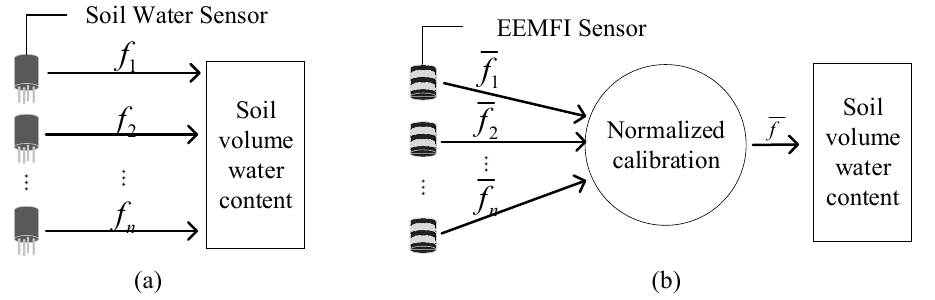
Figure 7. Comparison of calibration methods: ( a ) traditional calibration method and ( b ) normalized calibration method.